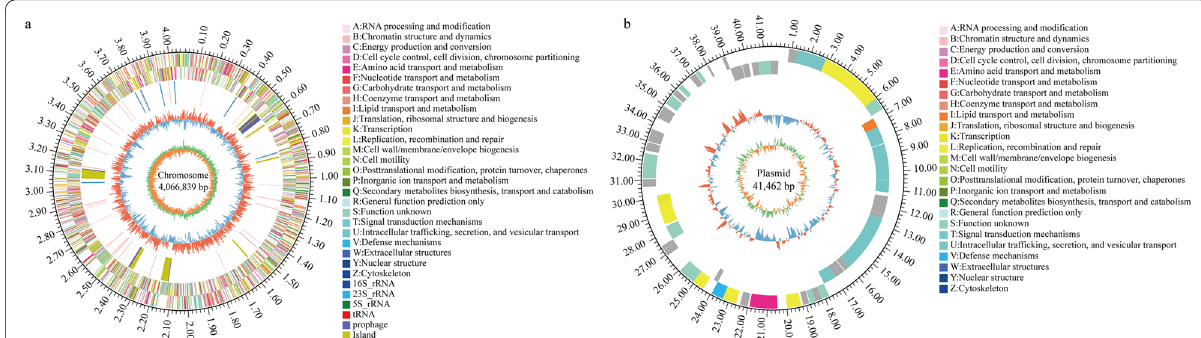
Fig. 5 Circular genome map of mutant strain YSD YN2. a chromosome; b plasmid. The circular genome map was created using Circos v0.69-6 with COG function annotation. From outside to inside, circle 1, the size of complete genome, each scale represents 20 kb; circles 2 and 3, the predicted protein-coding genes on the and - strands, different colors represent different COG function classification; circle 4, tRNA, rRNA, prophage and + island; circle 5, G C content, with > 57.45% G C in red, with 57.45% G C in blue; the inner circle, G C skew, with G% < C% in green, with + + ≤ + + G% > C% in